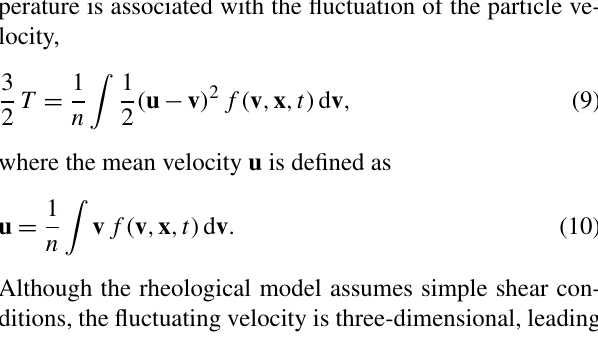
Figure 2. Simple shear flow setup with linear velocity profile u(z) . Flow variables included into the constitutive relation, e.g., the shear rate ˙ γ , normal stress σ and the shear stress τ , are consequently con-